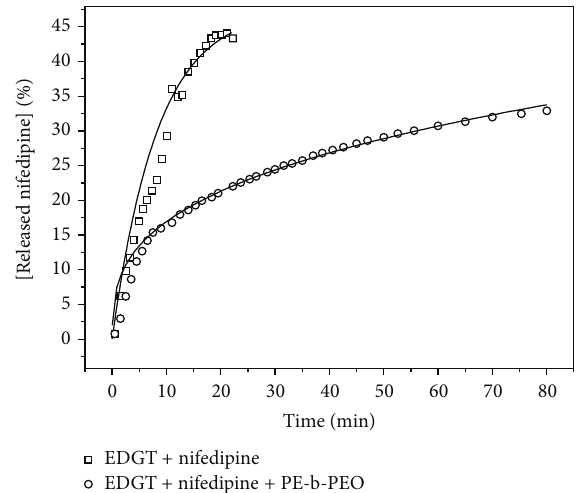
Figure 9: Comparison of release profile of nifedipine encapsulated by Eudragit L-100 and Eudragit L-100 +